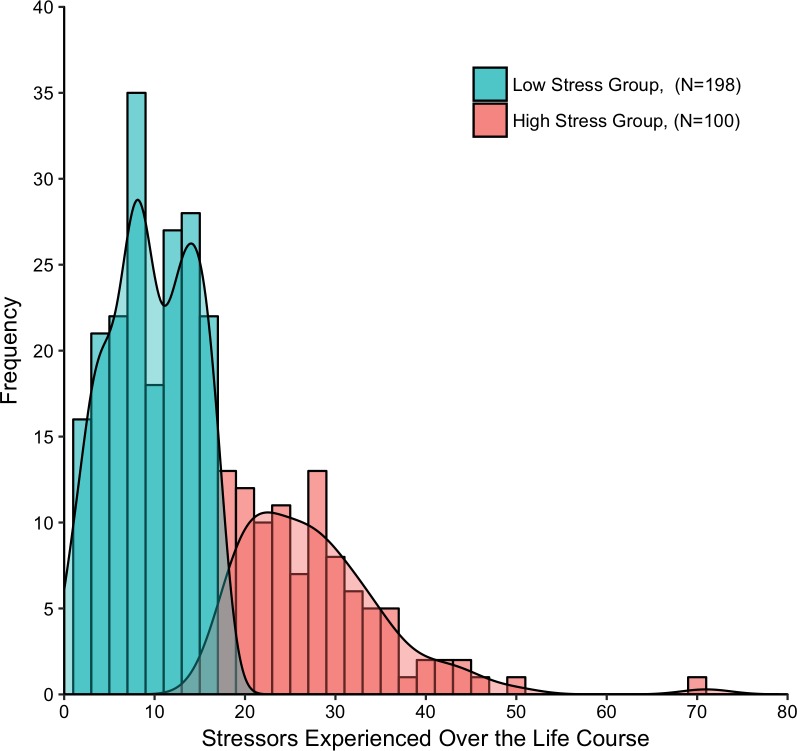
Latent structure of the lifetime stressor data.Two latent classes best fit the underlying distribution of the overall lifetime stressor count data—namely, a low-stress group (n = 198; total lifetime stressors: M = 9.52, SD = 4.69) and a high-stress group (n = 100; total lifetime stressors: M = 27.79, SD = 8.38).